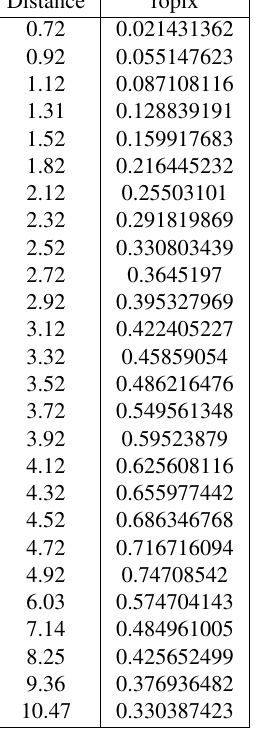
Table 6. Experiment Results of F